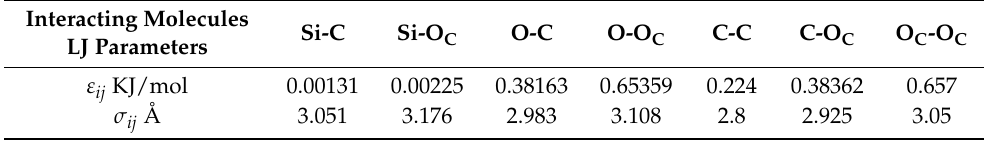
Table 1. Lennard–Jones parameters for the CO 2 –ZSM-22 interactions. Interacting Molecules